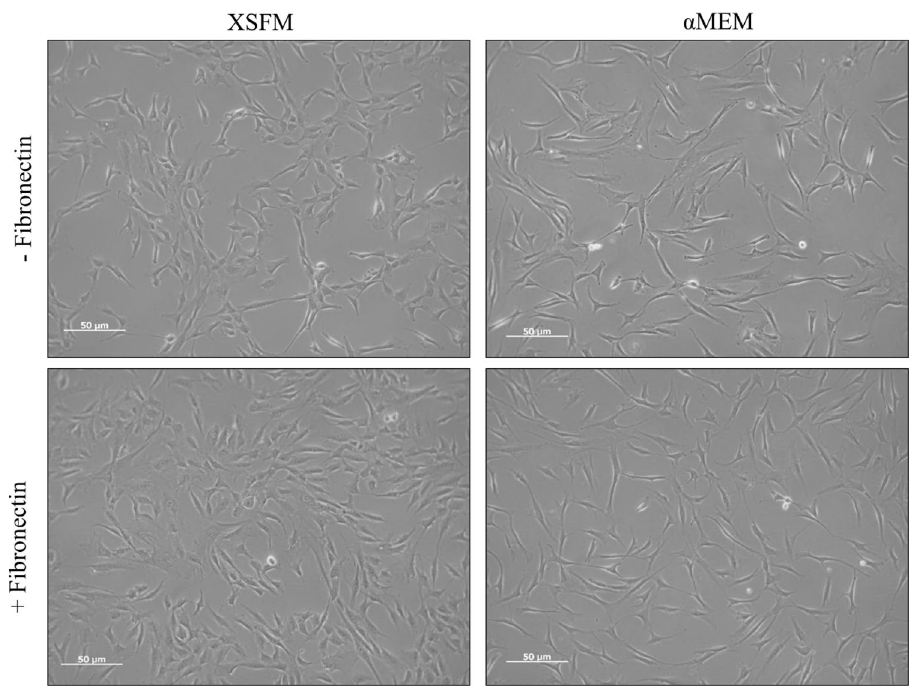
Figure 2. Representative images of BMSCs seeded on tissue culture plastic, with or without a 5 μg/ml fibronectin coating and cultured with αMEM/FBS/FGF2 or XSFM for 72 h. The Figure is representative of n = 5 biological